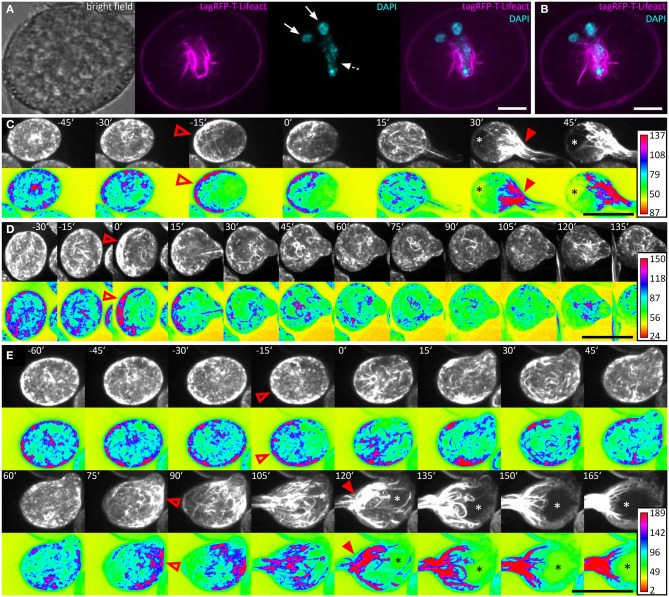
The actin cytoskeleton undergoes characteristic changes during pollen germination. Pollen expressing tagRFP-T-Lifeact was used for live-cell imaging of F-actin architecture and dynamics during pollen germination and growth. A single optical slice through a representative DAPI stained pollen grain is shown in (A). Solid arrows mark the sperm cells and dashed arrows the vegetative nucleus. A composite maximum intensity projection of 19 optical slices is shown in (B), the typical pattern of actin dynamics during pollen germinating is presented in (C). A pronounced F-actin network accumulates at the periphery of the pollen vegetative cell, opposite to the future site of PT outgrowth (open arrowhead). Rapid PT tip growth is associated with vacuole formation (asterisk) and the massive appearance of parallel F-actin bundles extending from within the pollen grain, into the pollen tube (solid arrowheads). In (D) a PT that failed to switch to rapid PT tip growth after bulging is shown. The germination of a second PT after first unsuccessful bulging is shown in (E). Maximum intensity projections of raw images and intensity based false-colored images are shown in (C–E) with respective calibration bars. Open red arrowheads indicate polar F-actin accumulation at the periphery of the pollen vegetative cell. Solid red arrowheads point at massively accumulating F-actin bundles that extend into the PT. Asterisks mark vacuoles. Time point 0′ indicates the last frame before germination. Scale bars: (A) 10 μm, (B) 5 μm (C–E) 25 μm.